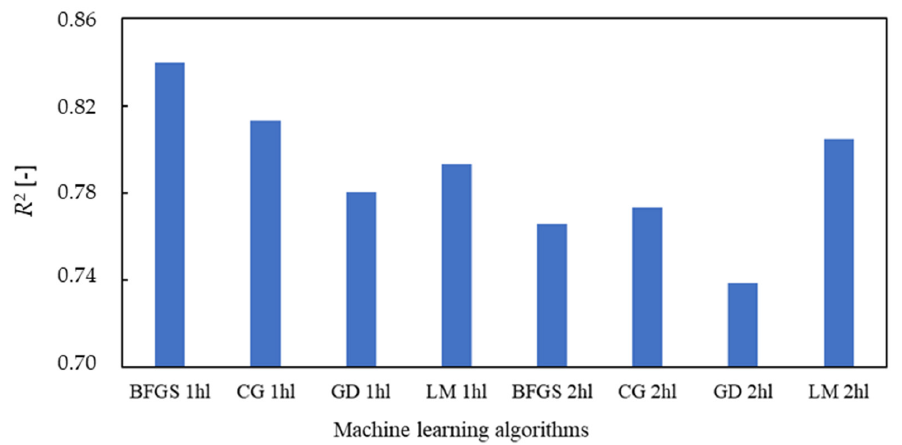
Figure 15. Comparison of models for predicting the pull-off strength of the surface layer f h due to the value of R 2 .